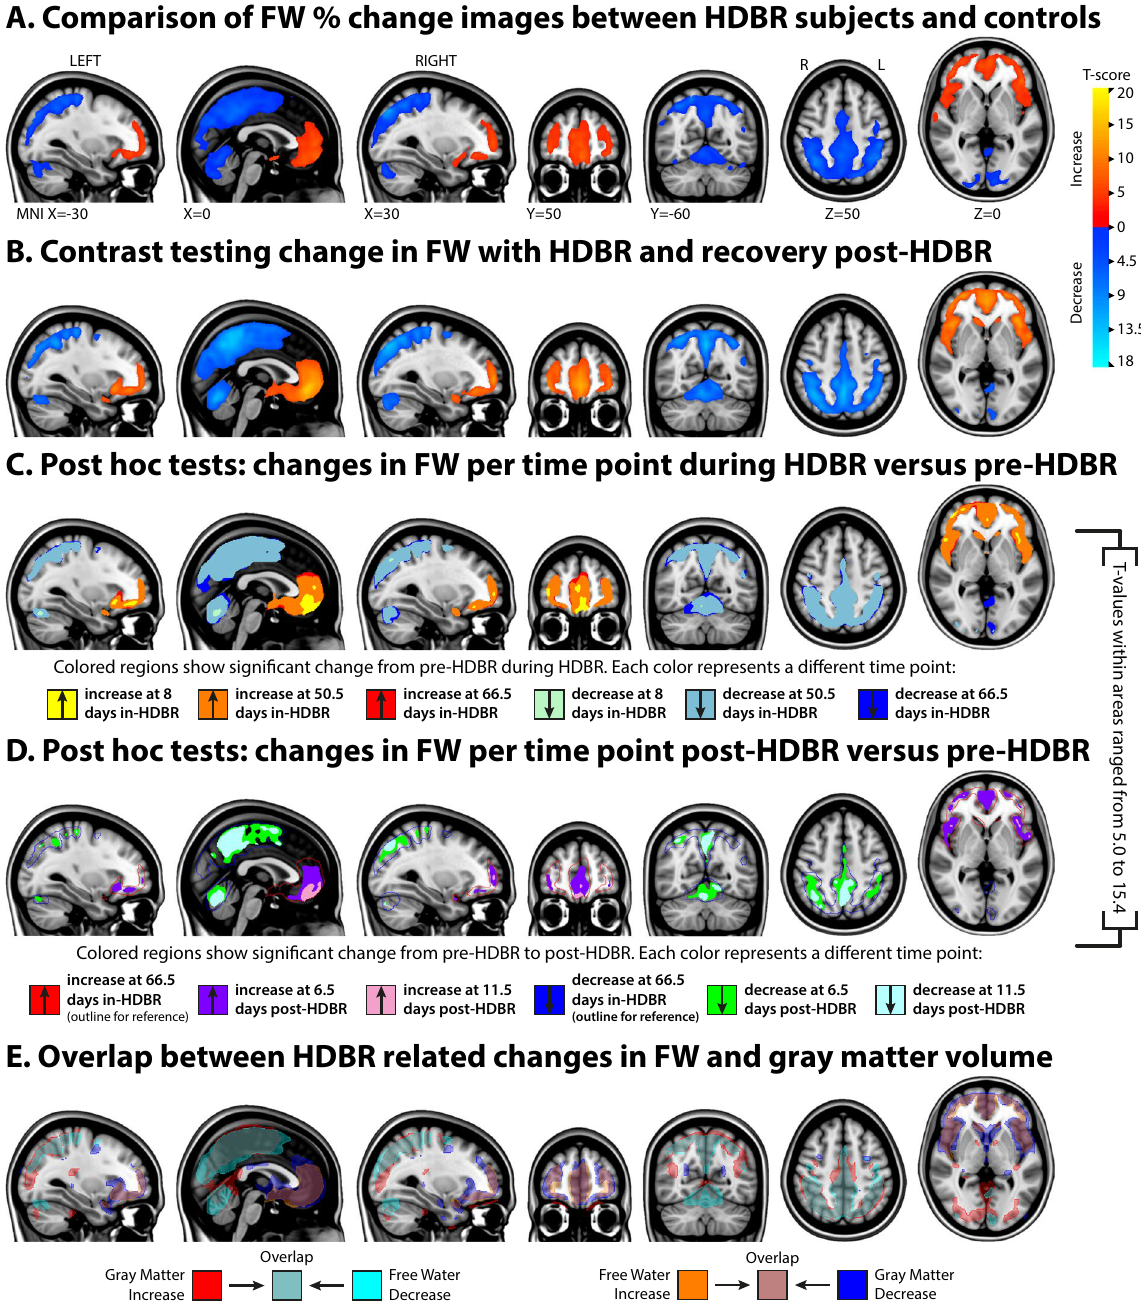
Figure 2. Effects of HDBR on Free Water distribution. Group level results of changes in FW are overlaid on the MNI152 common template. ( A ) Results from a paired-sample t-test comparing slope images of linear changes from pre-HDBR to the end of HDBR relative to changes over a similar time course in control subjects. Blue- to-light blue and red-to-yellow gradients show regions in which HDBR subjects show significantly larger FW decrease and increase respectively relative to control subjects. ( B ) Changes within HDBR subjects over all 7 time points following the linear mixed model contrast specified in Fig. 1B; ( C , D ) Results from post-hoc pairwise tests comparing pre-HDBR with time points during HDBR ( C ) and with post-HDBR ( D ). Each color indicates at which time point certain increases/decreases appeared first. The Regions that show significant increase and decrease early in HDBR expand in size with accumulating time in HDBR and diminish in size post-HDBR. Note: the red and blue outlines in ( D ) are actually the maximum effects of HDBR at 66.5 days in HDBR and serve as reference for the interpretation of recovery. ( E ) Overlap between regions with changes in Free Water and Gray Matter Volume ( unpublished data ) with HDBR; Coordinates indicate MNI152 space coordinates; all analyses are FWE